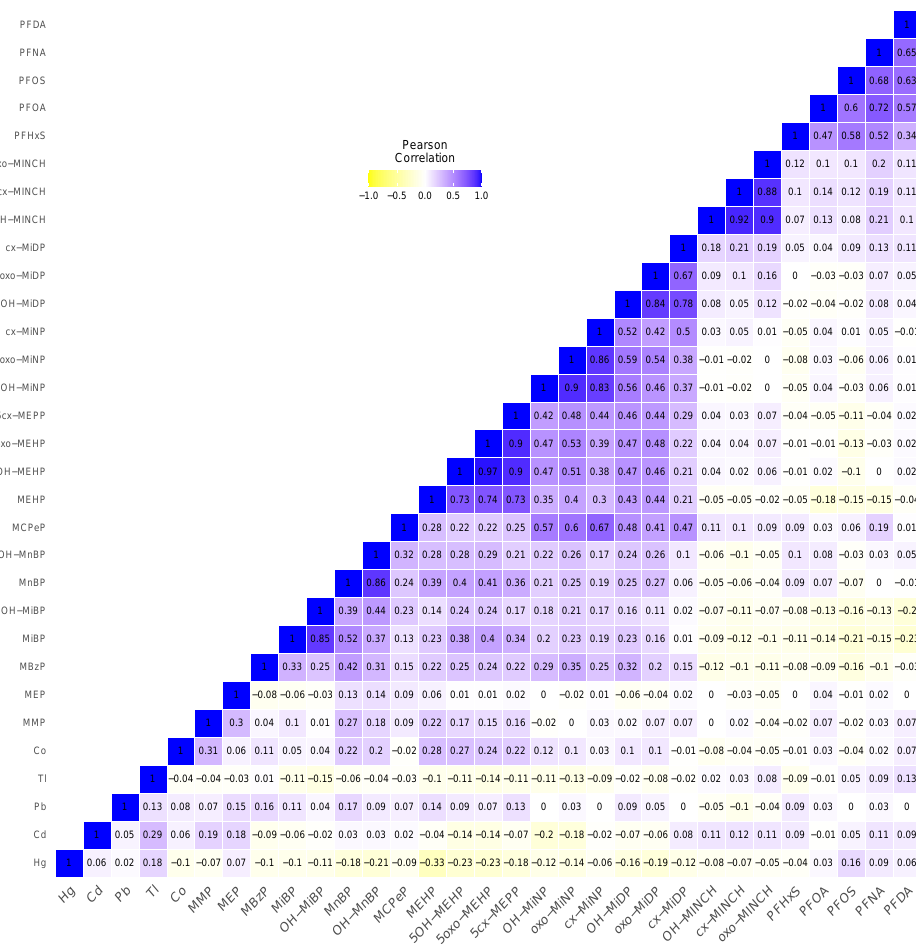
Figure 4. BIOAMBIENT.ES: heatmap showing the Pearson correlations between all measured creatine- standardised biomarkers available for the selected subset of participants. Data were corrected for sex, age, body mass index (BMI) and smoking status of the